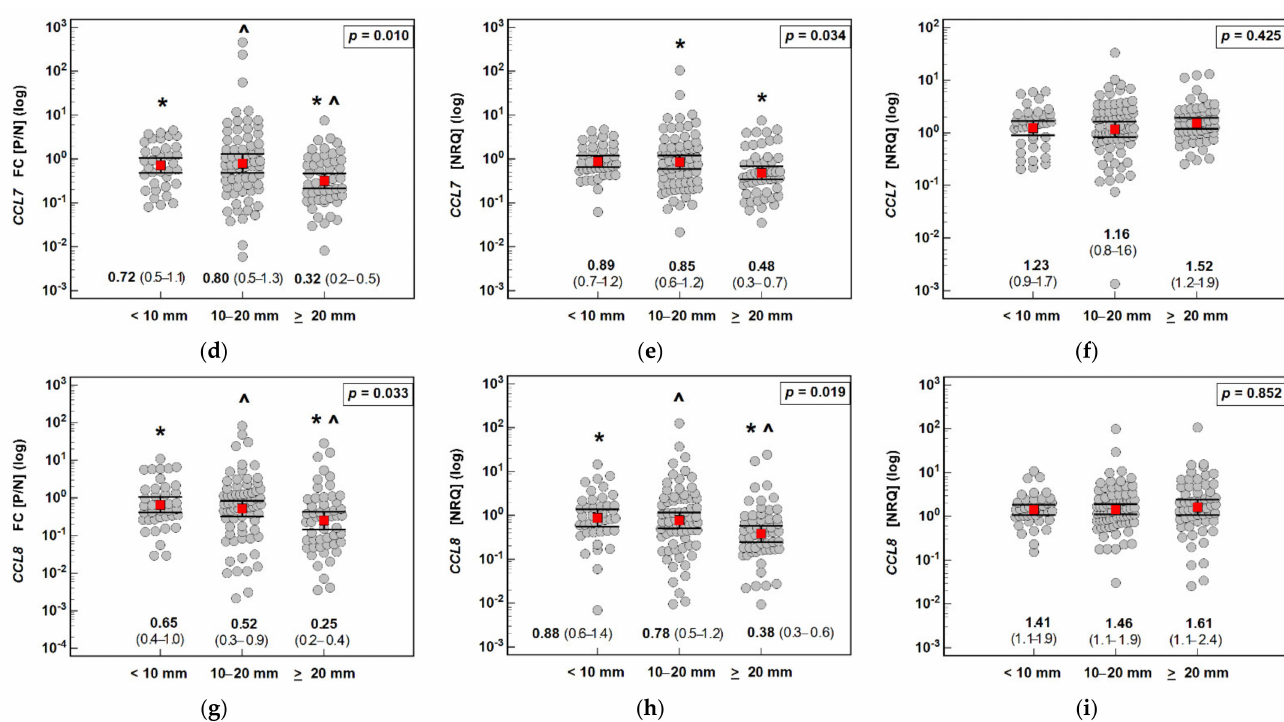
Figure 4. Effect of polyp size on the expression (mRNA) of MCP chemokines in patients with colorectal polyps: ( a ) fold change (FC) in CCL2 expression between the polyp and normal mucosa (P/N); ( b ) CCL2 expression in a polyp; ( c ) CCL2 expression in normal tissue; ( d ) fold change (FC) in CCL7 expression between the polyp and normal mucosa (P/N); ( e ) CCL7 expression in a polyp; ( f ) CCL7 expression in normal tissue; ( g ) fold change (FC) in CCL8 expression between the polyp and normal mucosa (P/N); ( h ) CCL8 expression in a polyp; ( i ) CCL8 expression in normal tissue. Data analyzed as logarithms using one-way ANOVA with a Student–Newman–Keuls post hoc test and presented as means with 95% confidence intervals (red squares with whiskers and numbers below the dot plots). Significant ( p < 0.05) differences between groups (identified in post hoc analysis) are indicated by the same symbol type (*, ˆ). NRQ: normalized relative